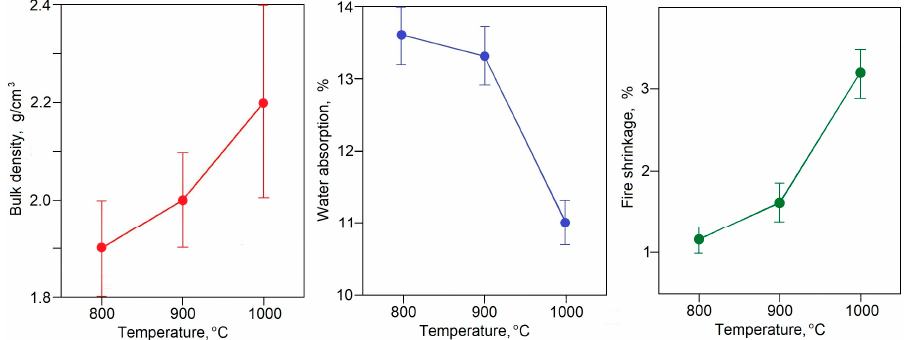
Figure 7. Dependences of bulk density, water absorption and fire shrinkage of ceramic materials obtained from modified saponite product on sintering temperature .